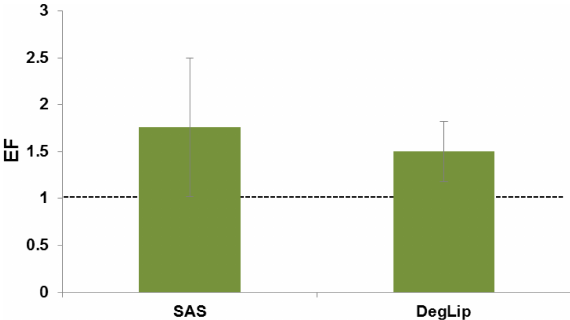
Figure 16. Average enrichment (EF) of surfactants (SASs) and dis- solved lipid classes indicating organic matter degradation